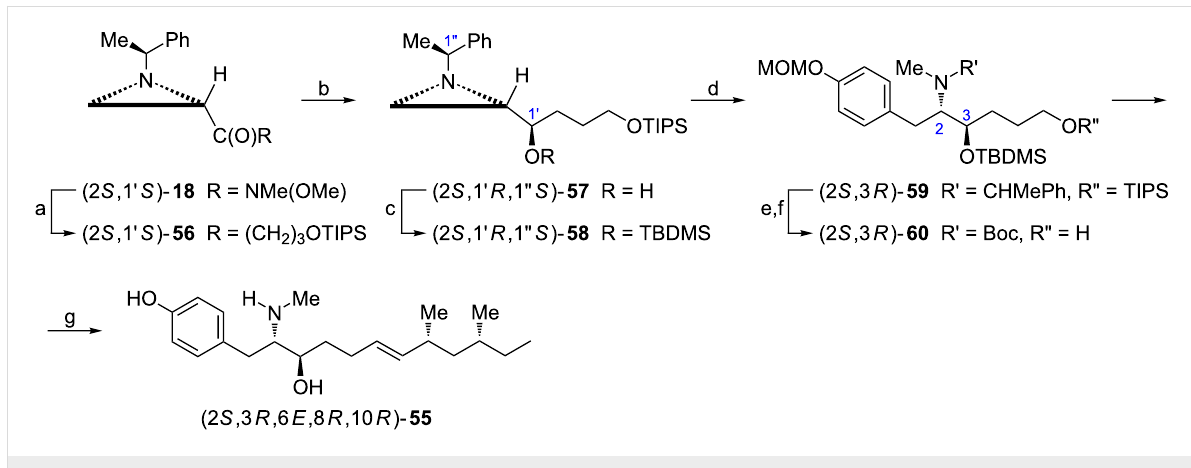
Scheme 16: Synthesis of natural tyroscherin ((2 S ,3 R ,6 E ,8 R ,10 R )- 55 ). Reagents and conditions: a) I(CH 2 ) 3 OTIPS, t -BuLi, ether, − 78 °C to rt, 2 h; b) NaBH 4 , ZnCl 2 , MeOH, − 78 °C, 0.5 h; c) TBDMSCl, DMAP, CH 2 Cl 2 , rt, 12 h; d) TfOMe, CuI, dioxane, rt, 0.5 h then 4-MOMOC 6 H 4 MgBr, THF, 0 °C, 10 min.; e) Et 3 N·HF, pyridine, rt, 26 h; f) H 2 , Pd(OH) 2 , EtOH, rt, 3 h then Boc 2 O, rt, 1 h; g) see ref. [56].